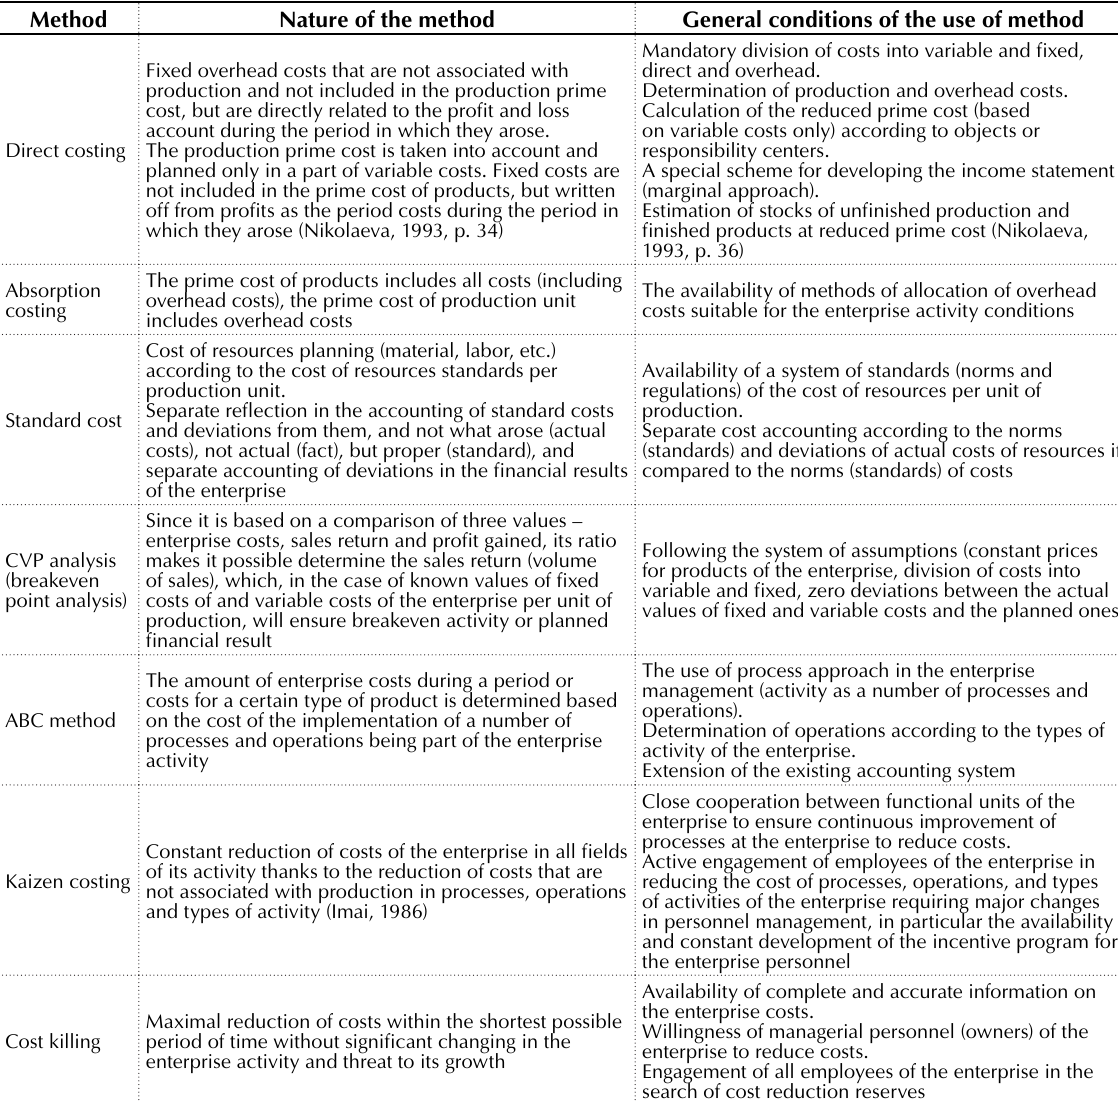
Table 1. The nature and general conditions of the use of methods of operational enterprise cost